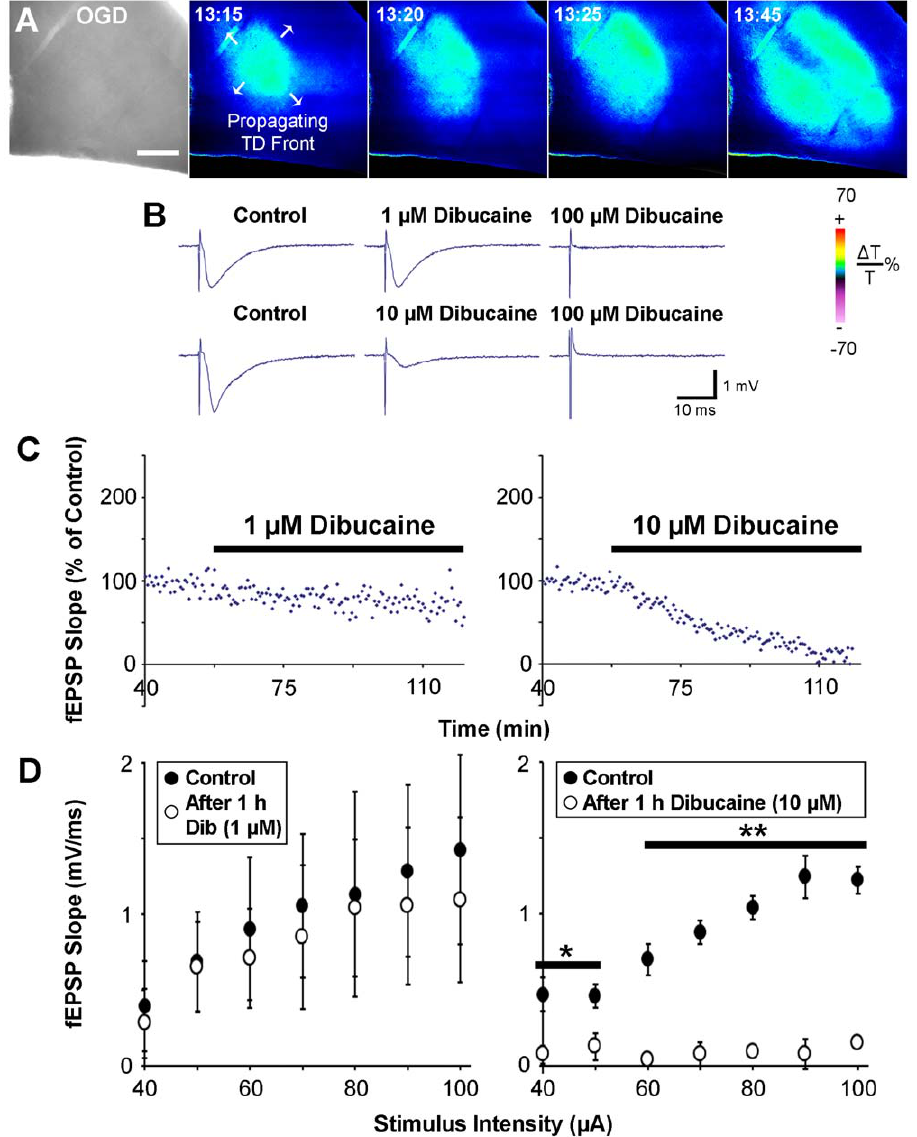
Figure 1. Global monitoring of terminal depolarization (TD) in human and mouse brain slices during dibucaine exposure. A , A slice is transilluminated and transmitted light is collected by CCD camera to create the digital bright field image (left). Following OGD at 0 min, the gray matter displays a propagating wave of elevated LT (signifying terminal depolarization), represented by pseudocoloring according to changes in pixel values of the image (color scale: below, right). In this example, terminal depolarization is ignited within 13 minutes of OGD and spreads in all directions (arrows). Scale bar, 500 m m. B , fEPSPs recorded from CA1 of st. radiatum in mouse hippocampal slices are not noticeably affected by 1 hour of superfusion with ACSF containing 1 m M dibucaine. 10 m M dibucaine partially inhibited the evoked synaptic response, while 100 m M dibucaine completely abolished synaptic activity. Each row represents traces recorded from a single slice. C , Summary of synaptic responses during dibucaine exposure. Following 1 hour of control recording in standard ACSF, slices were superfused with ACSF containing 1 m M (left panel; n=3 slices) or 10 m M dibucaine (right panel; n=3 slices). At the end of 1 hour treatment with 1 m M dibucaine, , 82% of the control fEPSP slope was preserved; 10 m M dibucaine reduced the fEPSP slope to , 14% of control values ( p , 0.0001 for both; one-way ANOVA). D , Input/output graphs showing mean fEPSP slope at various stimulus intensities before and after 1 hour treatment with either 1 m M (left) or 10 m M (right) dibucaine (n=3 slices for each concentration; * p , 0.05, ** p , 0.001; two-way ANOVA).